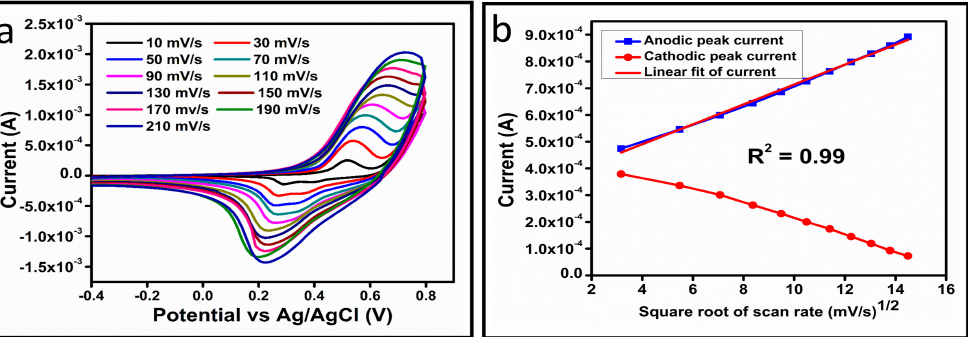
Figure 3. ( a ) CV curves of Sample 2 based on NiCo 2 O 4 nanomaterial, at various scan rates in the presence of 0.1 mM urea prepared in 0.1 M NaOH, ( b ) Linear plots of anodic and cathodic peak